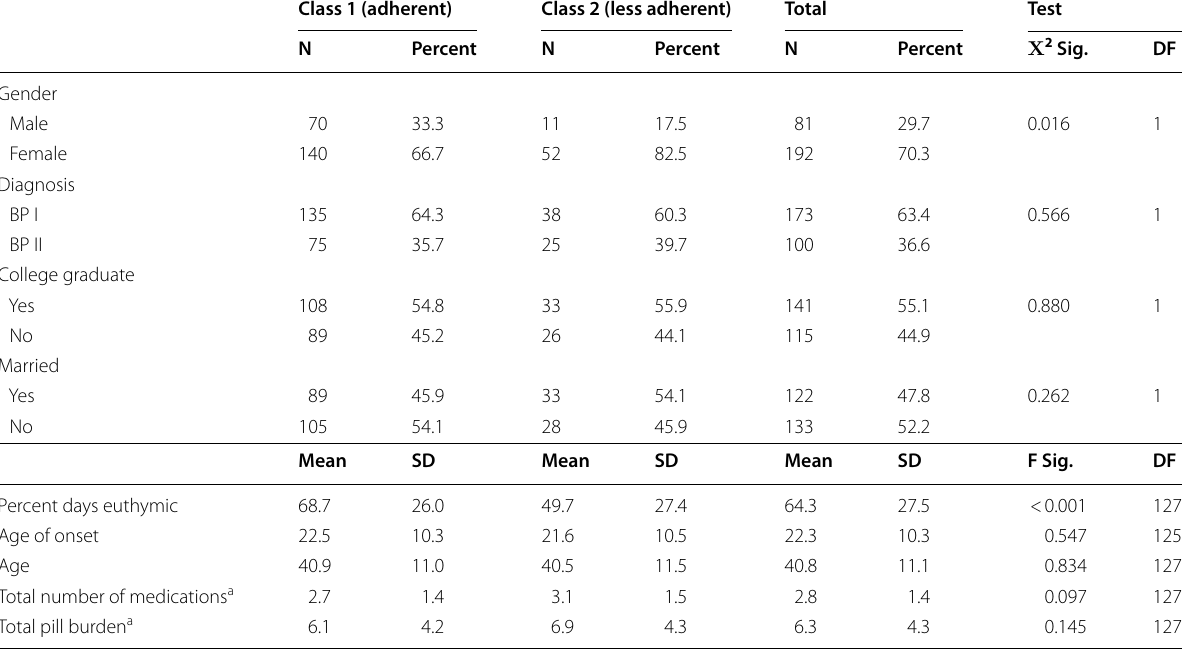
Table 4 Significant differences in the classes by LCMM class (N